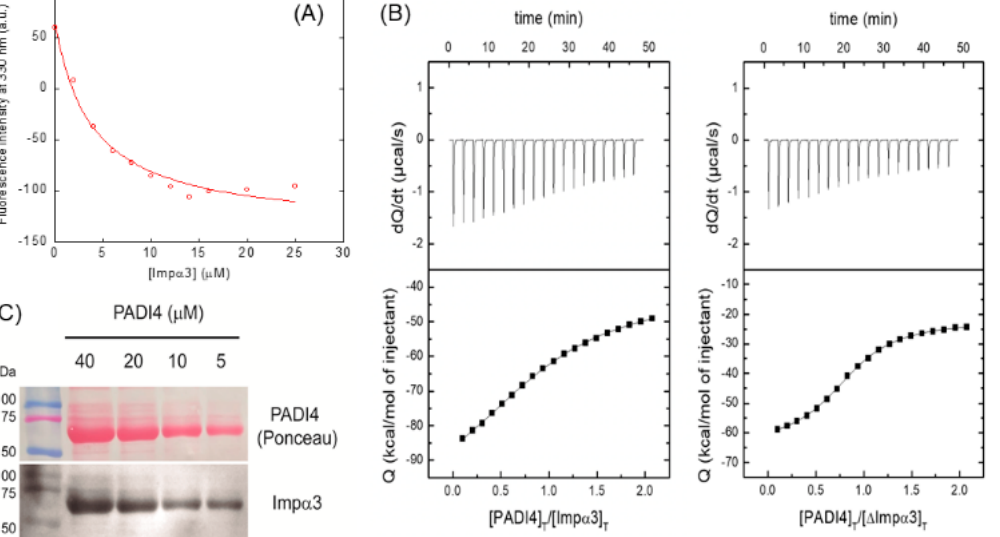
Figure 2. Binding of Imp α 3 to PADI4 as monitored by biophysical probes and Western blot analyses. ( A ) Titration curve monitoring the changes in the fluorescence at 330 nm when Imp α 3 was added to PADI4. The fluorescence intensity on the y -axis is the relative signal after removal of the corre- sponding blank. The line through the data is fitted to Equation (1). Experiments were carried out at 25 °C. ( B ) Calorimetric titrations for the PADI4 binding to ( left ) Imp α 3 and ( right ) Δ Imp α 3. Upper panels show the thermograms (thermal power as a function of time), and lower panels show the binding isotherms (ligand-normalized heat effects per injection as a function of the molar ratio in the calorimetric cell). Continuous lines correspond to the fitting curves according to a single ligand binding site interaction model. Experiments were carried out at 25 °C. ( C ) Polyacrylamide gels were loaded with several concentrations of PADI4 as visualized with Ponceau staining. Nitrocellulose membranes were later incubated with Imp α 3 to see the binding, washed, and revealed with the corresponding antibody against Imp α 3. Table 1. Thermodynamic parameters of binding of PADI4 to the different macromolecules a .